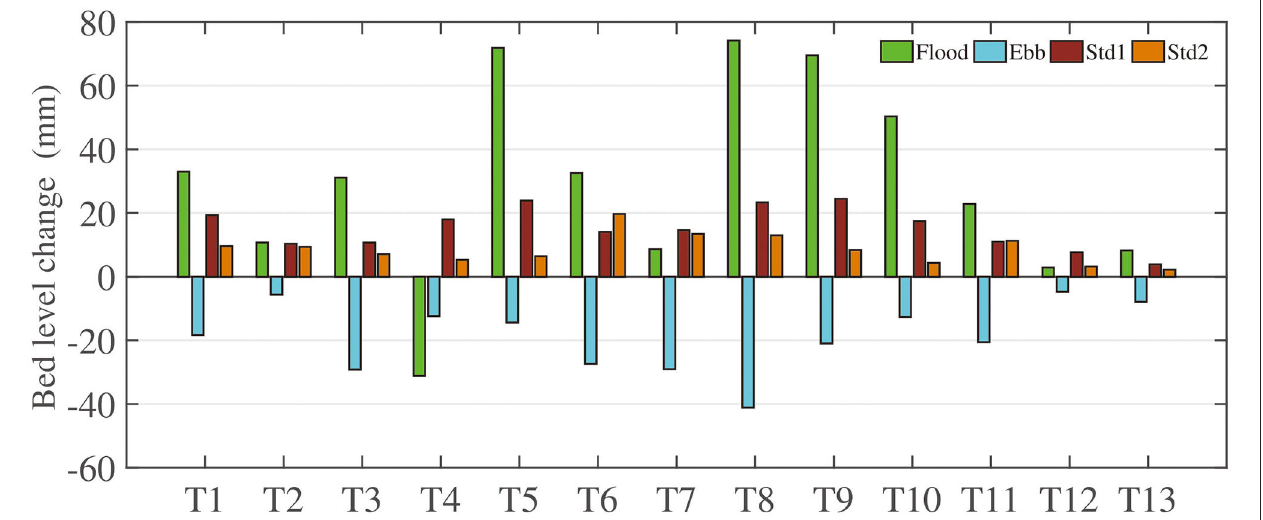
FIGURE 5 | Net bed level changes of the flood tide (green bar) and ebb tide (light blue bar) of each tidal cycle, and the SD of bed level changes during the flood tide (Std1, brown bar) and ebb tide (Std2, orange bar) of each tidal cycle. Note that not all the submerged bed level data were